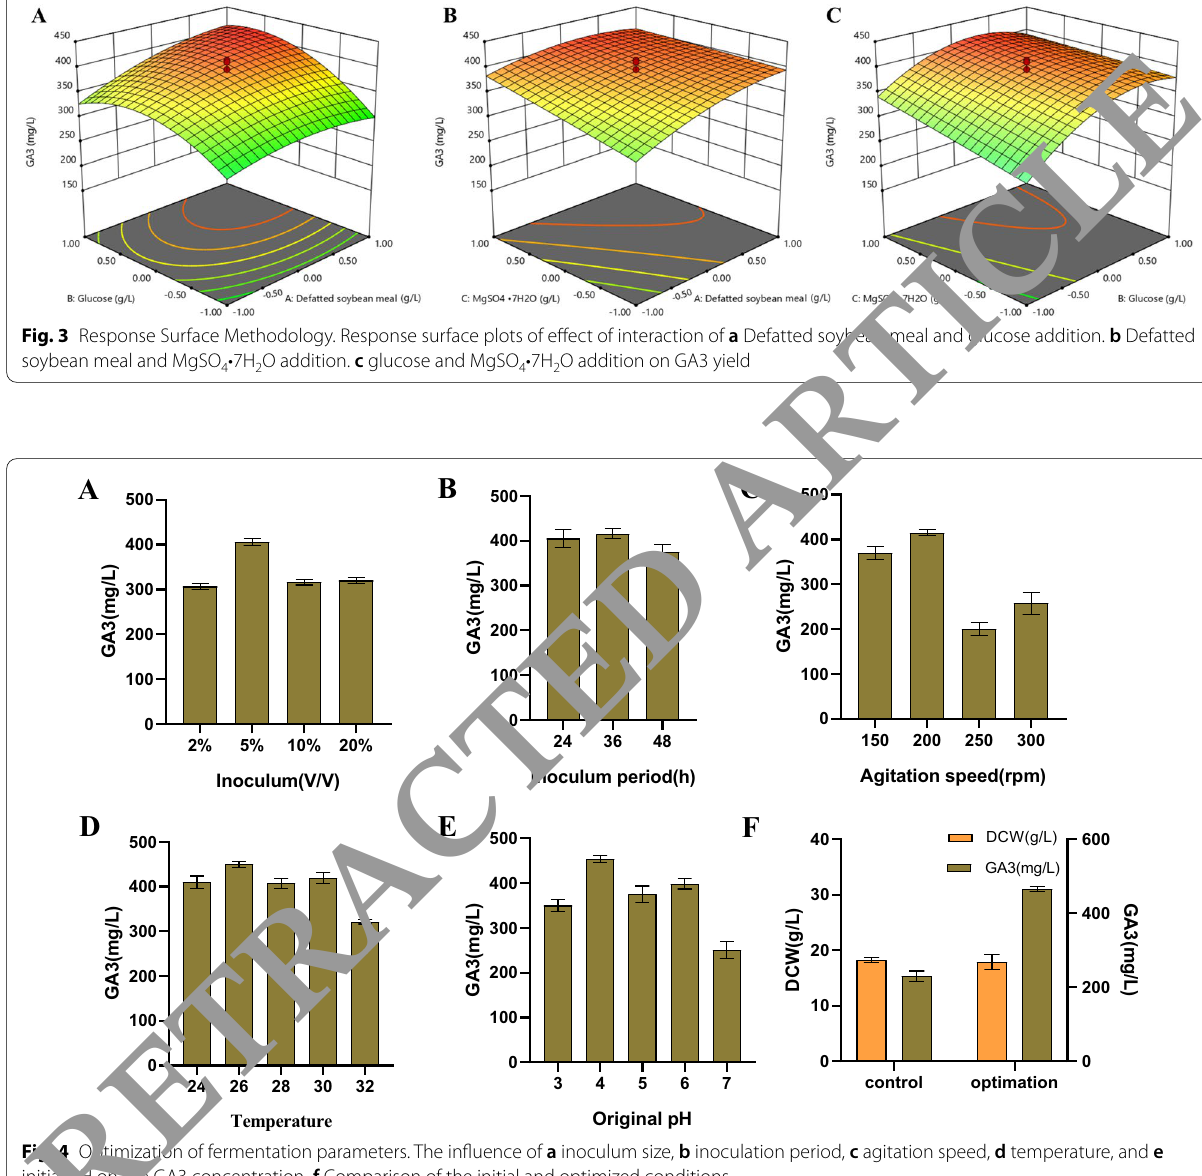
Fig. 4 Optimization of fermentation parameters. The influence of a inoculum size, b inoculation period, c agitation speed, d temperature, and e initial pH on the GA3 concentration . f Comparison of the initial and optimized conditions